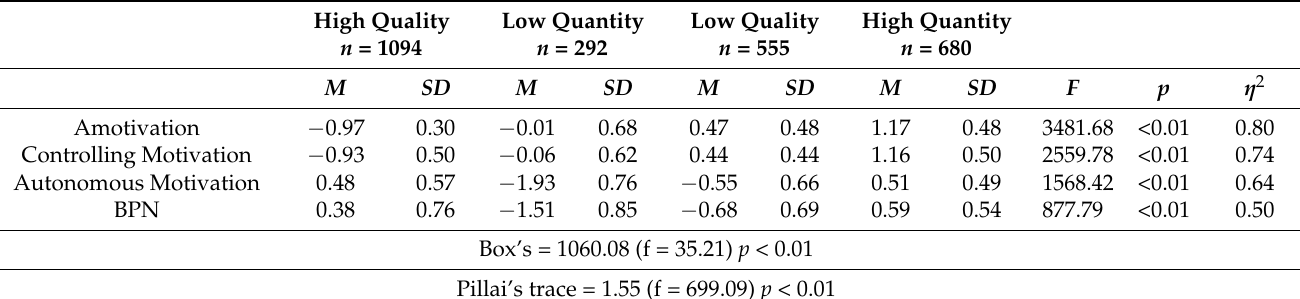
Table 2. Differences in the variables of the motivational profiles.